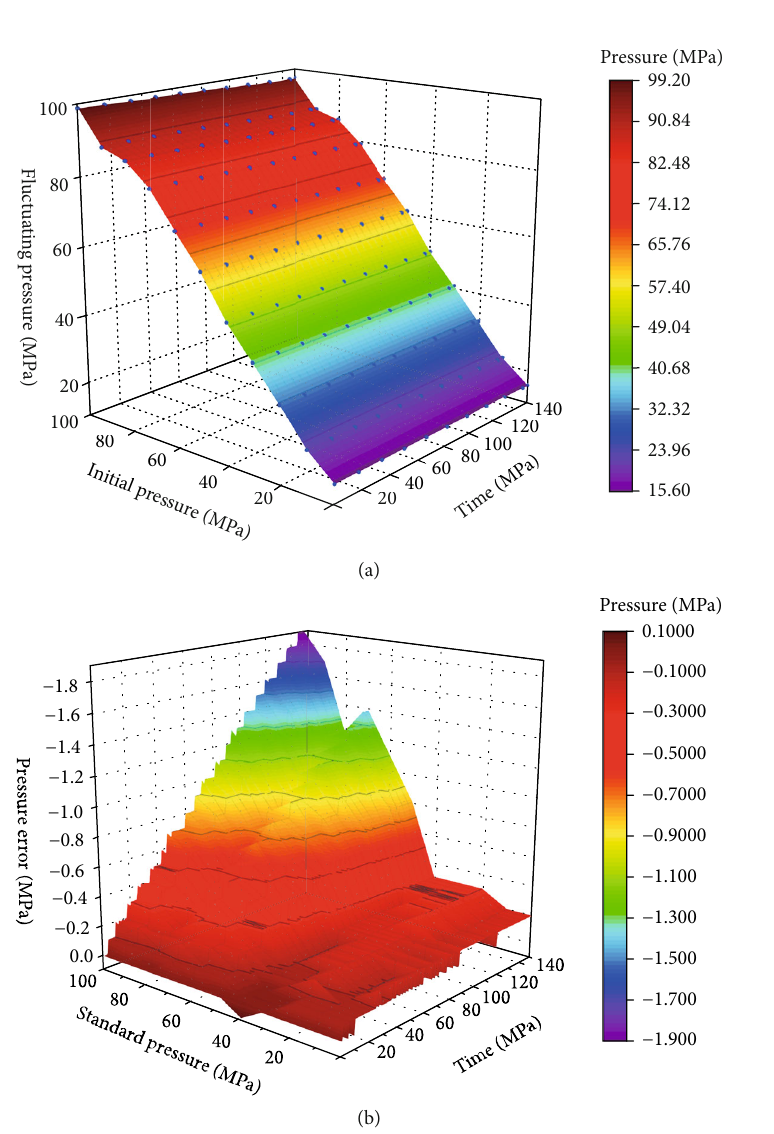
Figure 13: Test results for the test chamber. (a) Pressure-holding capacity of the high-pressure test chamber. (b) Pressure leakage rate of the high-pressure test chamber.